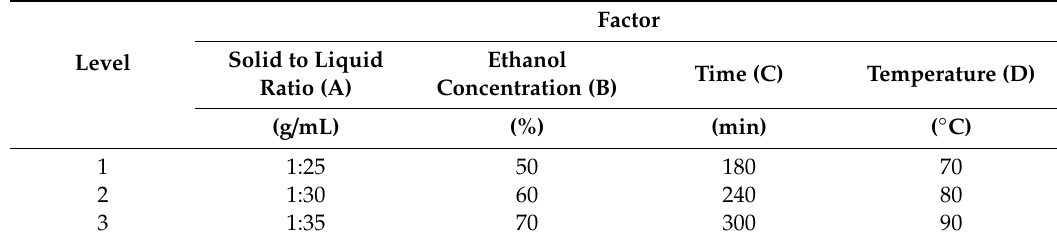
Table 1. Factors and levels of L 9 (3 4 ) orthogonal experiment.